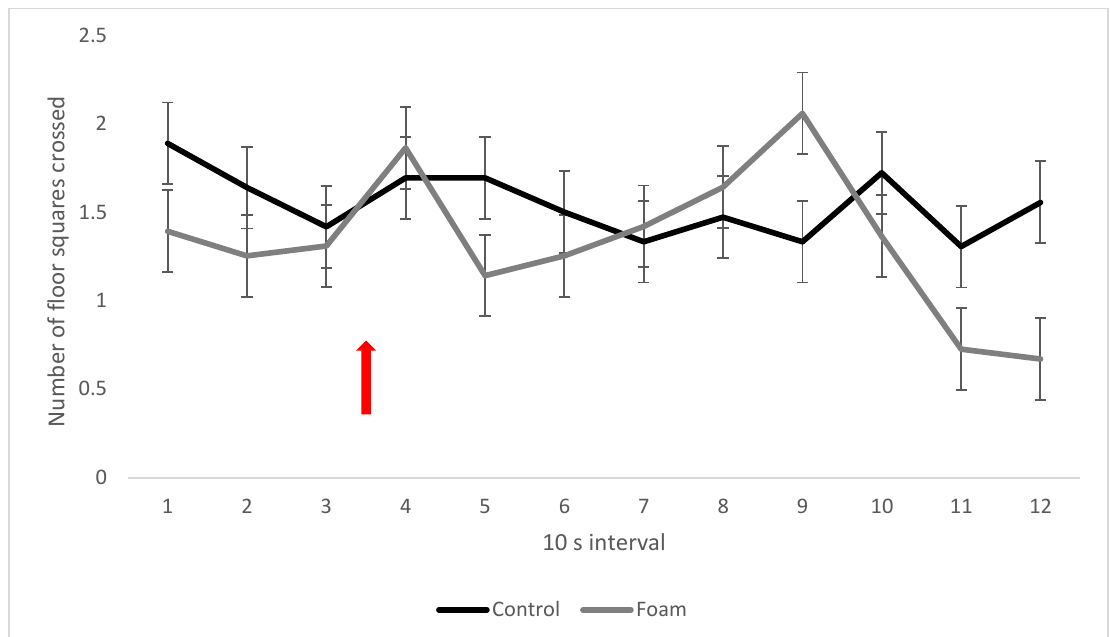
Figure 3. Activity within the foam box described by mean number of floor squares crossed by pigs per 10 s interval for the control and foam treatments. Red arrow indicates time of foam start. Values given are LSM ± SE. Lack of overlap of SE error bars indicates significant pairwise differences ( p < 0.05) between treatments or over time between intervals. Overall p -value for the interaction: p = 0.017.